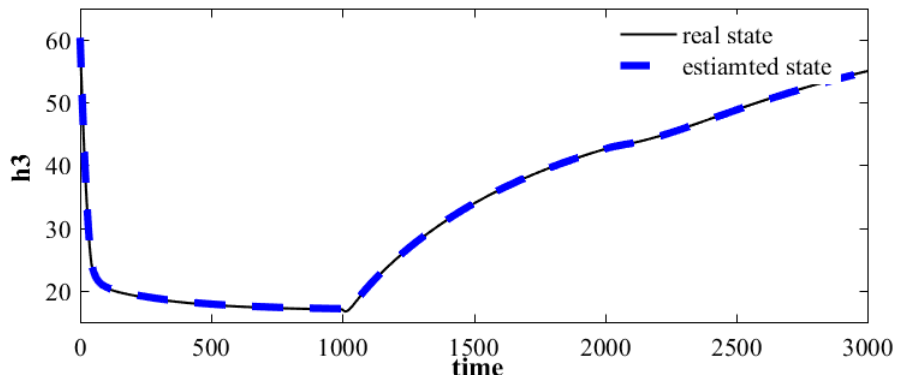
Figure 10. Correlation oefficient based h 3 estimation (noise free).